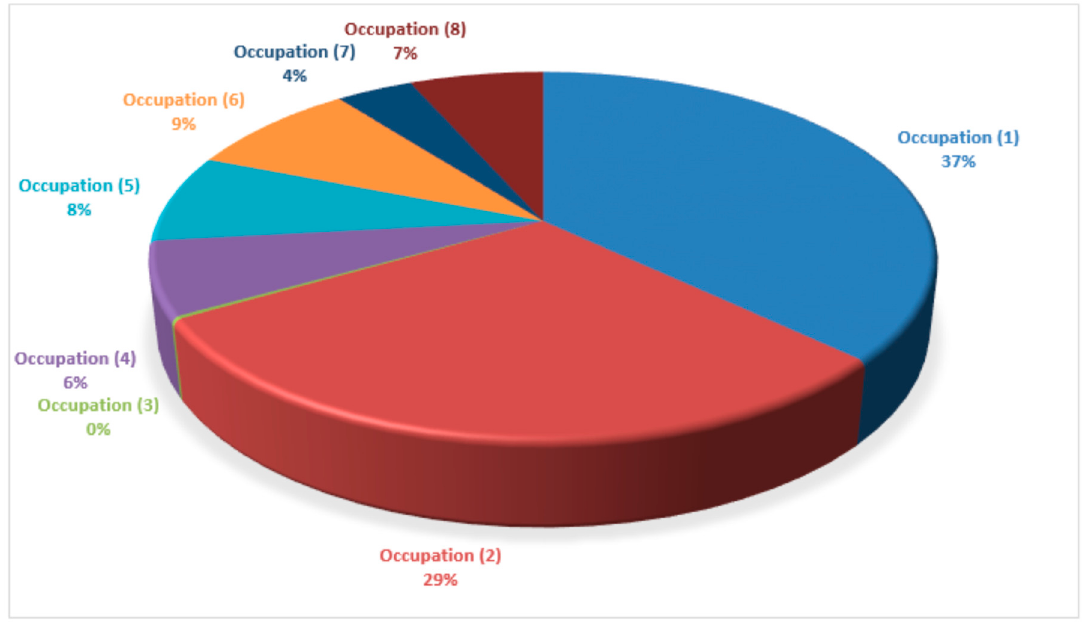
Figure 1. Pie chart display of the total occupation representation from the pool of participants that completed the COVISTRESS questionnaire.